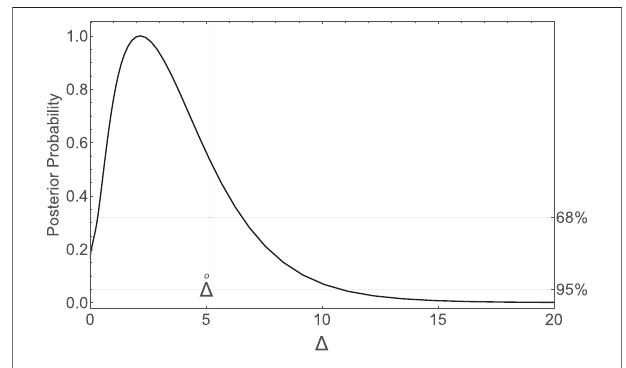
FIGURE 9 | Marginalized posterior probability distribution for Δ . The value ~ Δ x 5 . 17 ℓ 2 Pl selectedbytheblackholeentropyconsiderationsisdenoted by the vertical line. It lies within 1 σ of the marginalized mean value 3 . 86 ℓ 2 Pl that lies to the right of the peak. Thus, there is an unforeseen internal